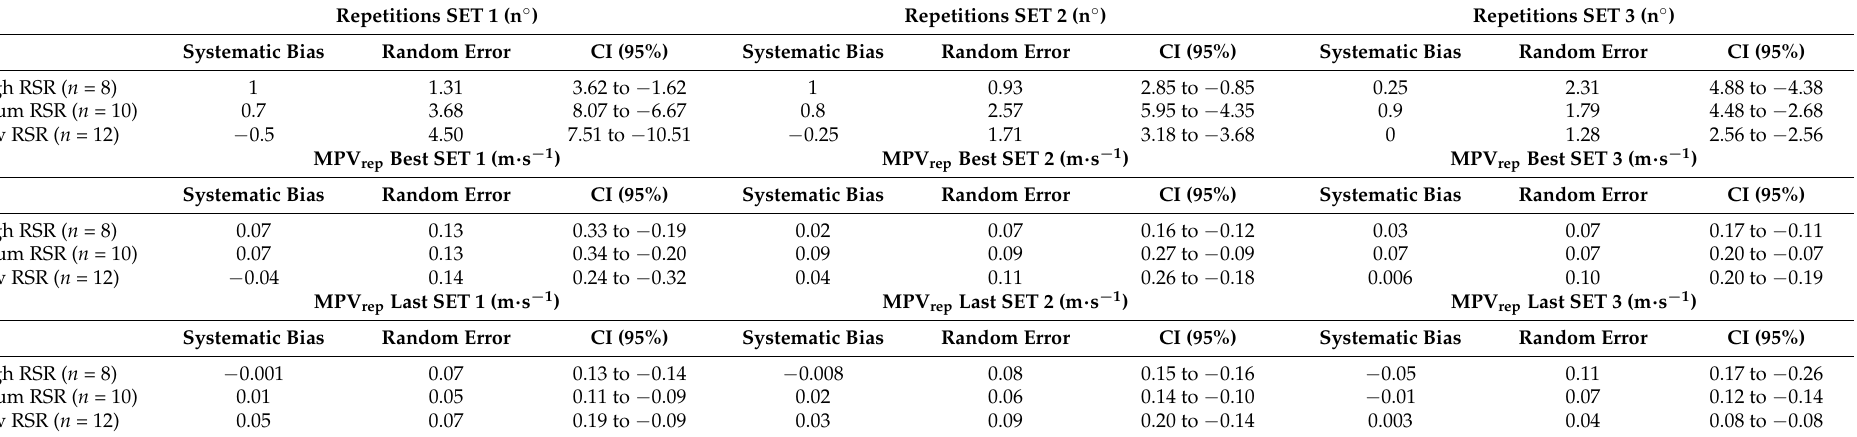
Table 4. The Bland–Altman plots in the intrasubject variability [test (T2)–retest (T3)] assessment of the bench press exercise protocol performed, best repetition and last repetition on two different days for the four strength